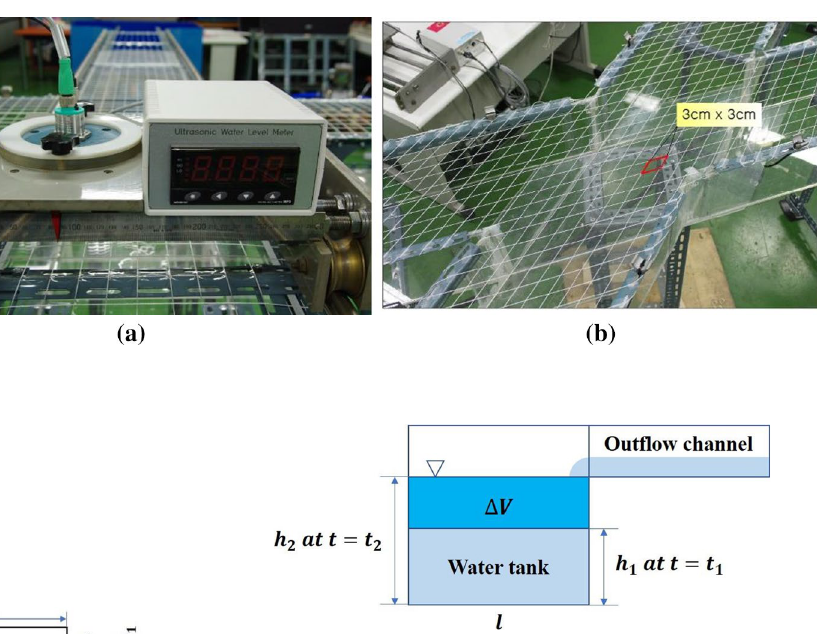
Fig. 6 Schematic illustration of outflow